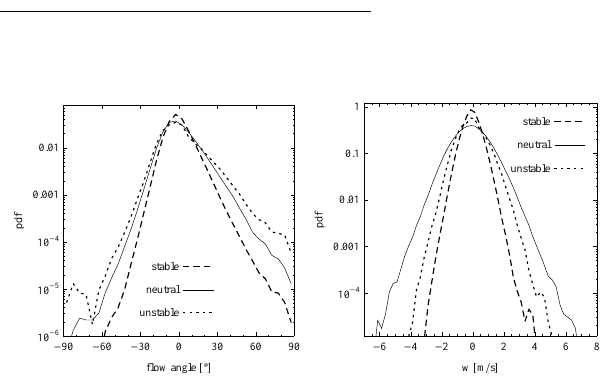
Fig.3. Probabilitydensityofattackangleonsonicanemometer(left)andverticalvelocitiesforthreeatmosphericstabilitysubsets(right) basedonSolentR210Hzdata. Fig. 3. Probability density of attack angle on sonic anemometer (left) and vertical velocities for three atmospheric stability subsets (right) based on Solent R2 10Hz